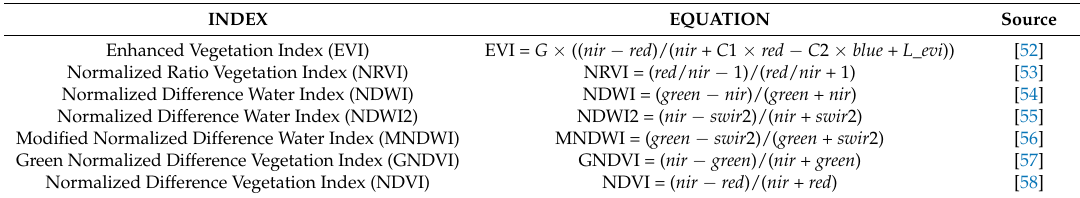
Table 3. Selected spectral indices calculated, according to